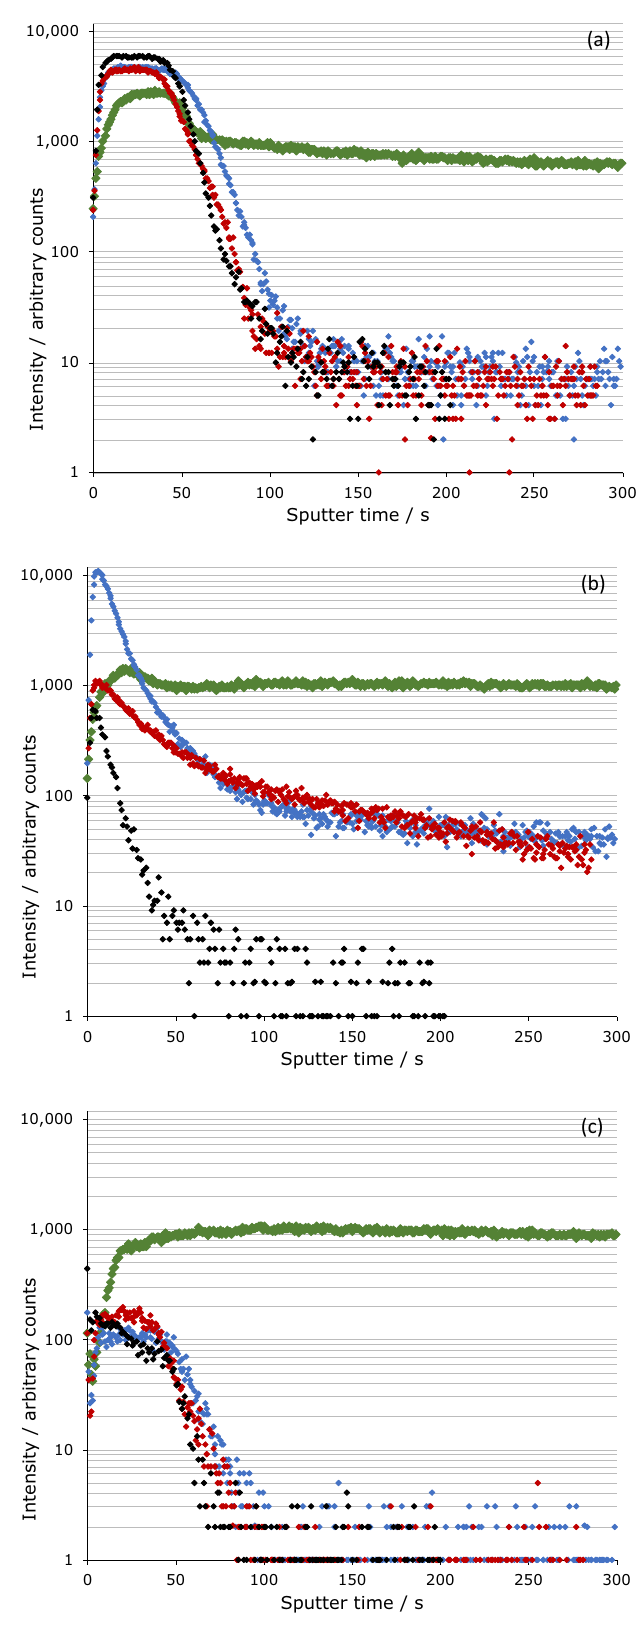
Figure 3. ToF–SIMS depth profiles for the PD surfaces, showing the change in ion intensity over time for (a) 54 FeO − , (b) BO − and (c) Fe − . The colours correspond to the ionic liquid used PBOB (green), PBMB (blue) 2 2 B 3 O 3 and PBScB (red), with the untreated surfaces shown separately